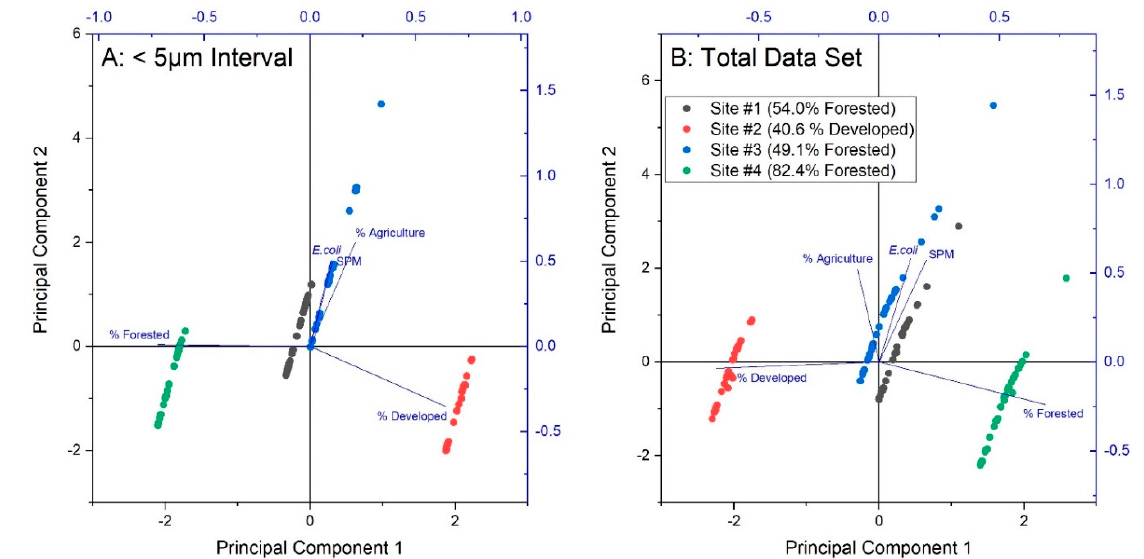
Figure 8. Results of principal components analysis, including biplots A) showing the data in the smallest interval ( E. coli and SPM) and B) the total data set (defined as all he SPM and E. coli data >0.7 µm), for extracted principal components of E. coli concentration and SPM concentration at four monitoring sites during study period (20 July 2018–27 October 2018) in West Run Watershed, West Virginia, USA.